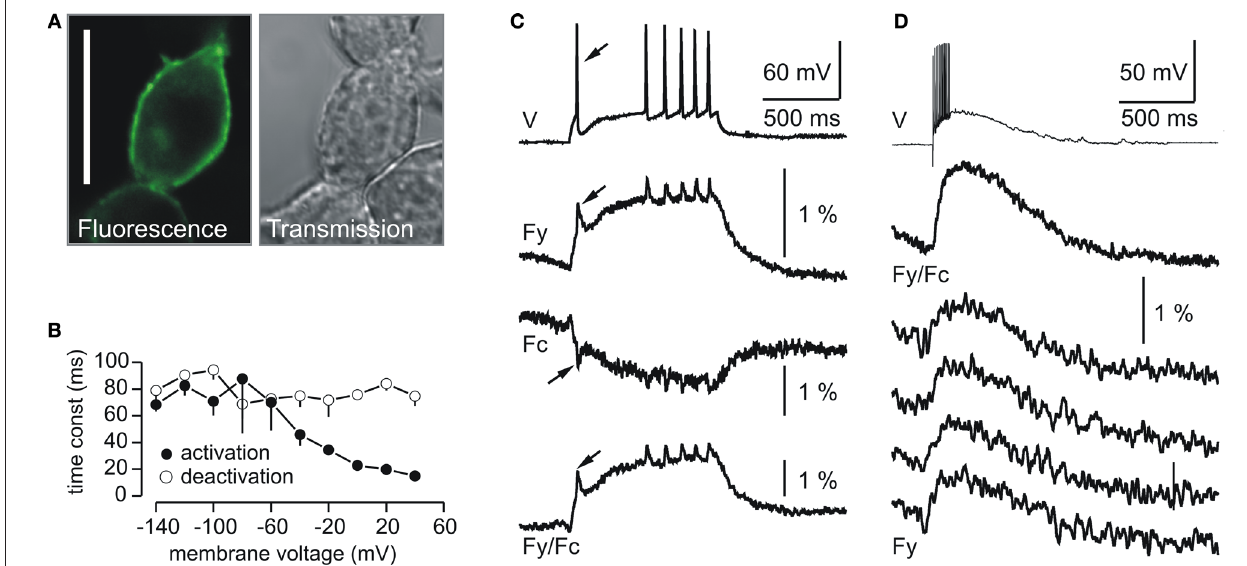
FIGURE 1 | Plasma membrane expression and fl uorescence response properties of VSFP2.1. (A) Confocal fl uorescence and transmission images of PC12 cells transfected with VSFP2.1. Note the targeting of VSFP2.1 to the plasma membrane. Scale bar is 25 µm. (B) Voltage dependence of apparent activation and deactivation time constants of VSFP2.1 fl uorescence signals in PC12 cells at 35 ° C. (C,D) VSFP2.1 fl uorescence responses to physiological neuronal membrane signals. VSFP2.1-expressing PC12 cells were voltage- clamped with membrane voltage traces recorded from olfactory mitral cells